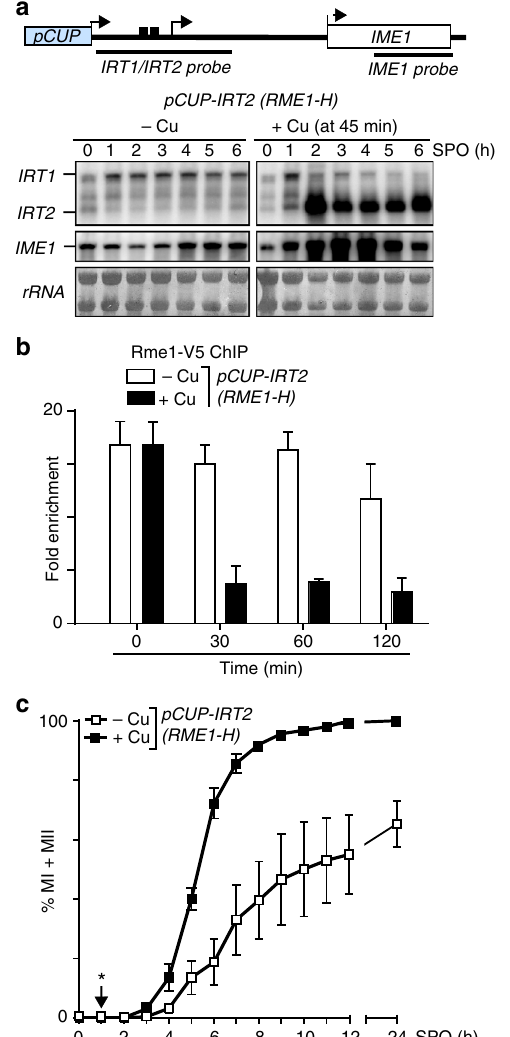
Fig. 2 IRT2 transcription interferes with Rme1 binding, and promotes IME1 expression a IRT2 , IRT1 , and IME1 expression in diploid cells harboring pCUP-IRT2 and RME1-H tagged with the V5 epitope tag (FW2060) by northern blot. Cells were pre-grown in rich medium, pre-sporulation medium, before shifted to SPO and were either not treated ( − Cu) or treated with copper sulfate ( + Cu) after 45 min in SPO. Samples were taken at the indicated time points. Northern blot membranes were hybridized with a probe that detects both IRT1 and IRT2 , and a probe that detects IME1 . As a loading control, the ribosomal RNA is displayed. b Similar as a , except that binding of Rme1 to the IME1 promoter was determined by chromatin immunoprecipitation using V5-antibodies coupled to agarose beads in cells that were either not treated ( − Cu), or treated with copper sulfate ( + Cu). Samples were taken at the indicated time point after treatment, formaldehyde crosslinked, and chromatin extracts were prepared. Rme1- DNA complexes were isolated by immunoprecipitation, and the recovered DNA fragments were quanti fi ed by qPCR using a primer pair directed against the Rme1-binding sites in the IME1 promoter. The signals were normalized to the silent mating locus ( HMR ), where Rme1 does not bind. The means± SEM of n = 4 experiments are shown. c Similar as a , except that kinetics of meiotic divisions were determined. Means ± SEM of n = 3 experiments are shown. *Indicates the time of treatment with